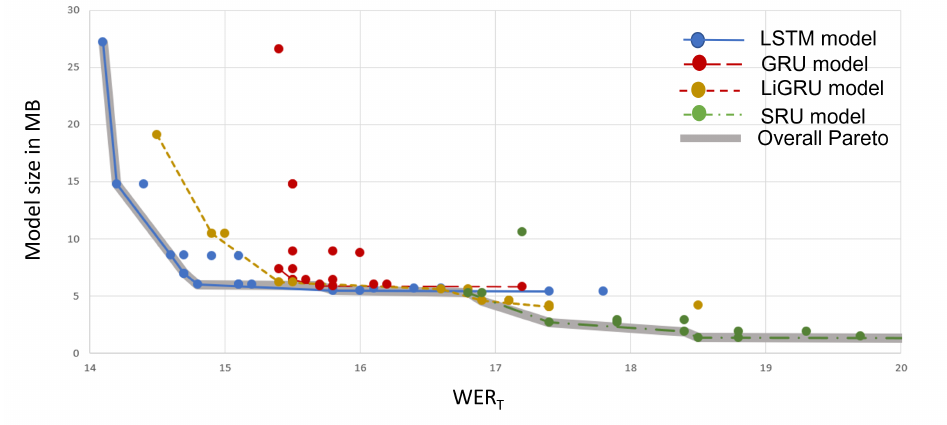
Figure 7. The size of compressed models at different error levels. For each model, we connect the best points using a line. Then we highlight the best points of all models with a gray shadow.